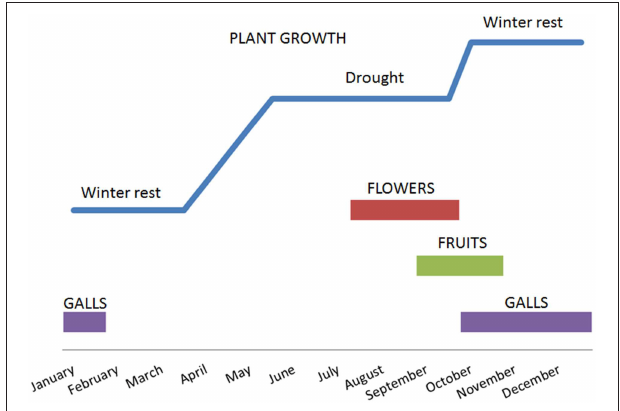
FIGURE 1 | Evolution of the phenology of D. viscosa in 2014 in the olive groves